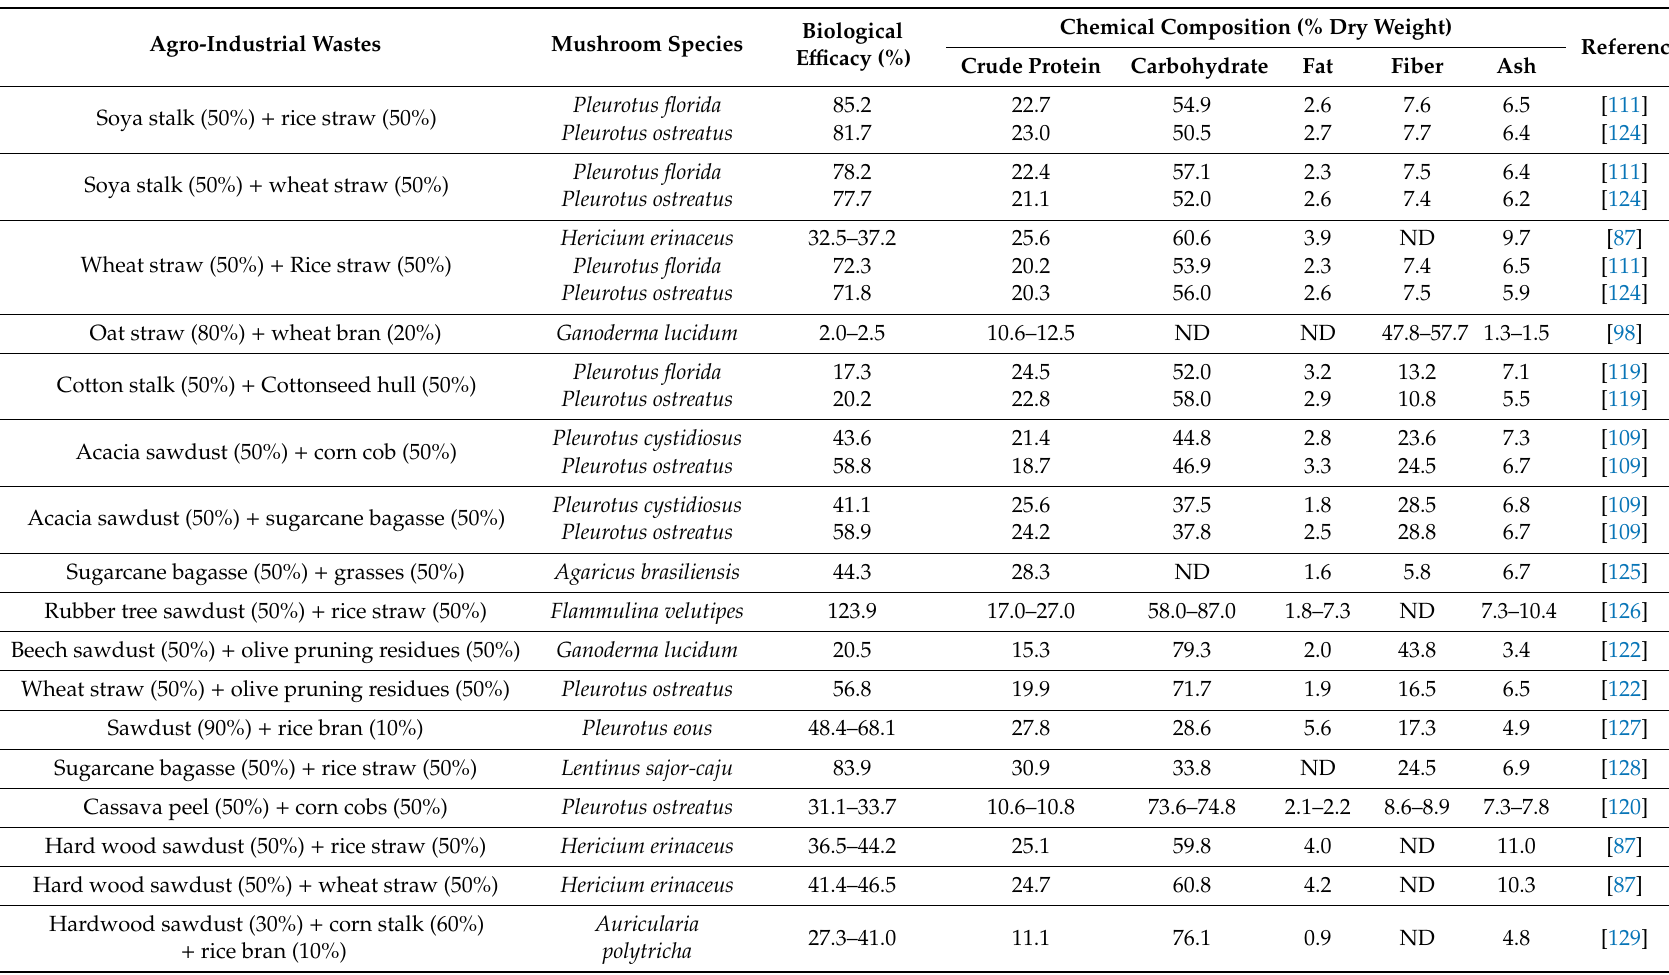
Table 4. Biological e ffi ciency and chemical composition of some mushrooms grown on the combination of agro-industrial wastes. Agro-Industrial Wastes Mushroom